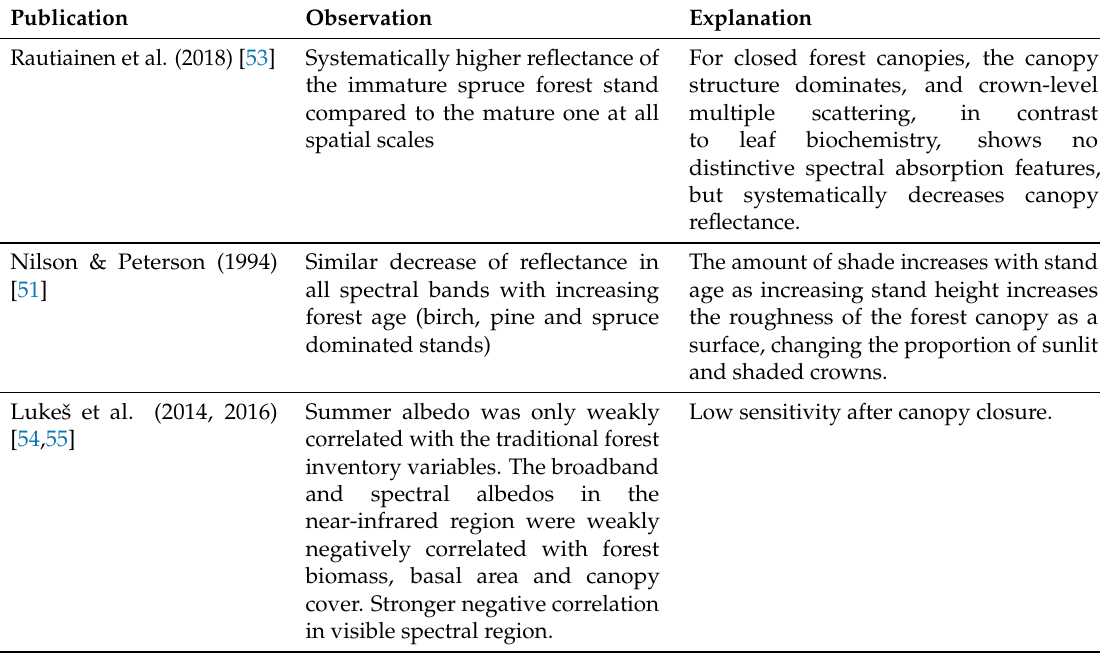
Table 4. Comparison with findings and explanations by other